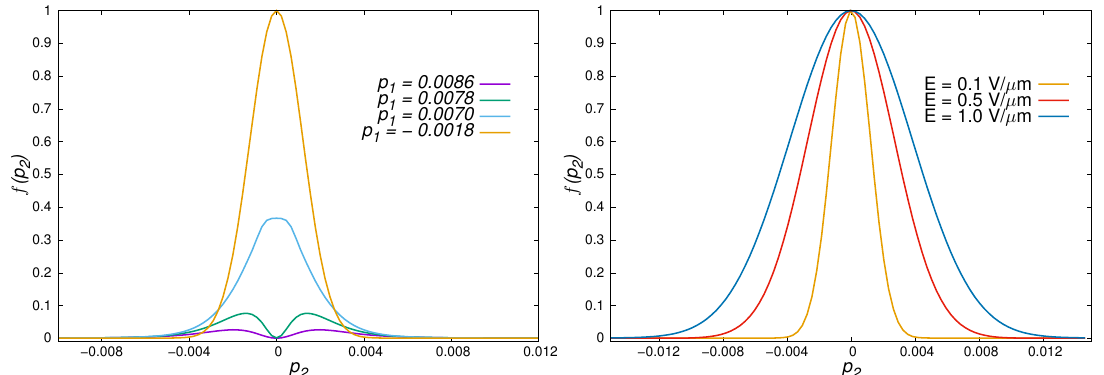
Figure 2. Left panel : The section of the distribution function f ( p 1 , p 2 ) for several values of p 1 at the field strength 0.1 V/ µ m; Right panel : The shape of the section f ( p 1 , p 2 ) for p 1 = field strength E